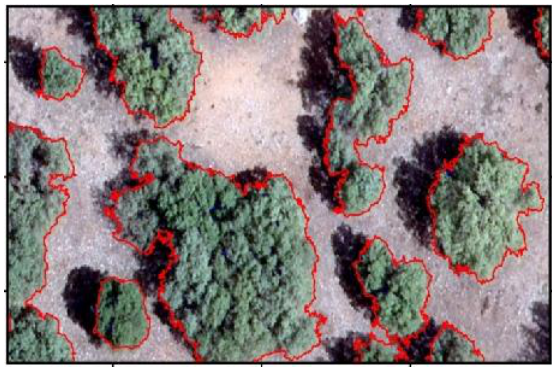
Figure 5. A part of UCD imagery classified by kNN technique with